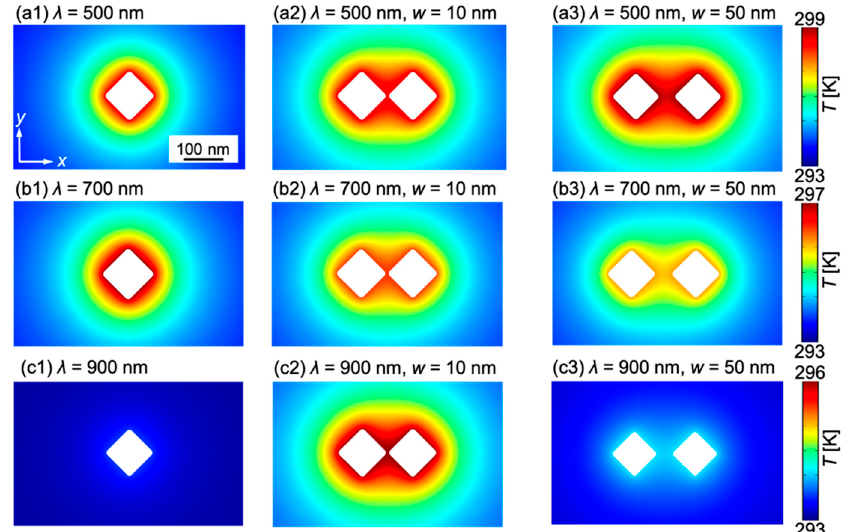
Figure 7. Temperature field T in xy cross section at the center of the structure: ( a1 ) A gold nanostructure at λ = 500 nm, ( a2 ) two gold nanostructures at λ = 500 nm, w = 10 nm and ( a3 ) λ = 500 nm, w = 50 nm. ( b1 ) A gold nanostructure at λ = 700 nm, ( b2 ) two gold nanostructures at λ = 700 nm, w = 10 nm and ( b3 ) λ = 700 nm, w = 50 nm; ( c1 ) A gold nanostructure at λ = 900 nm, ( c2 ) two gold nanostructures at λ = 900 nm, w = 10 nm and ( c3 ) λ = 900 nm, w = 50 nm.